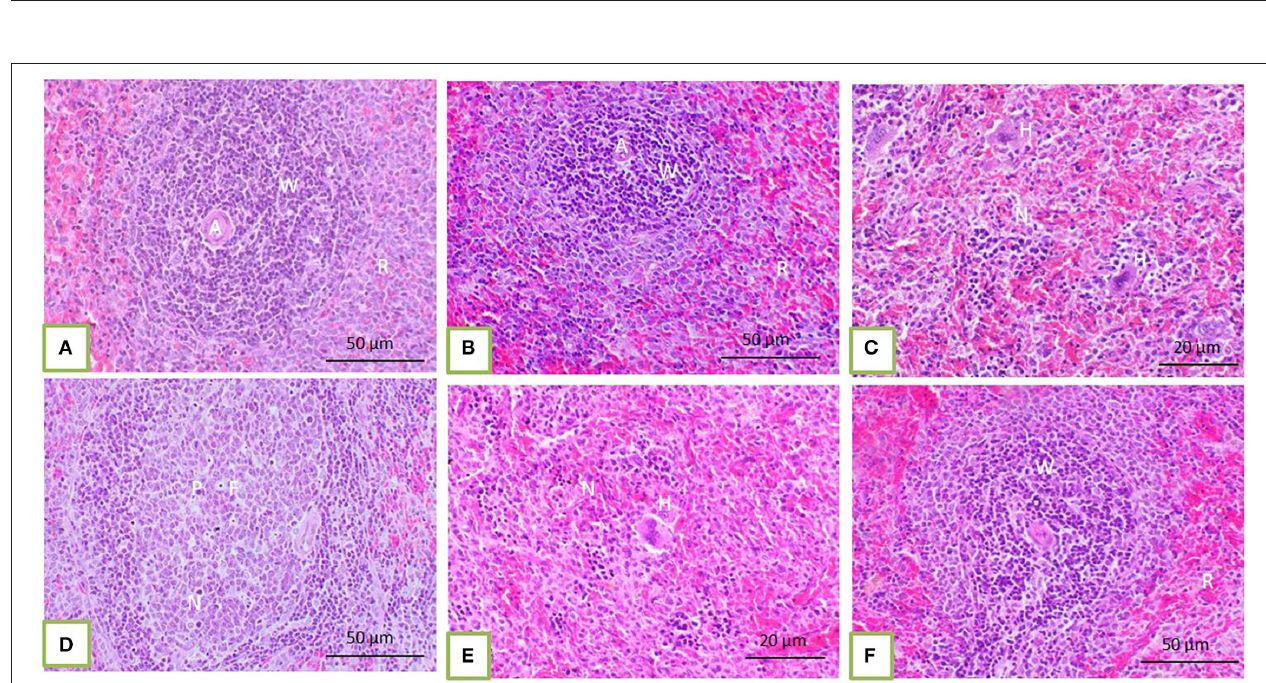
FIGURE 2 | The spleen of control rats and those treated with 100, 200, and 300 mg/kg BW bLf showed distinct white and red pulps. The white pulp (W) comprises small, medium, and large lymphocytes and plasma cells with intact arteriole (A) . The red pulp (R) is composed of venous sinuses with various cell types (A,B) . The spleen of rats treated with Bz showed a moderate degree of EMH (H) in the red pulp (C) in addition to apoptotic hematopoietic cells (P) and necrotic areas (N) containing foamy macrophages (F) present among white and red pulps (D) . The spleen of rats treated with Bz + 100 and 200 mg/kg BW bLf showed less EMH (E) . However, the spleen of rats treated with Bz + 300 mg/kg BW bLf showed similar morphology to that in the control group (F) .